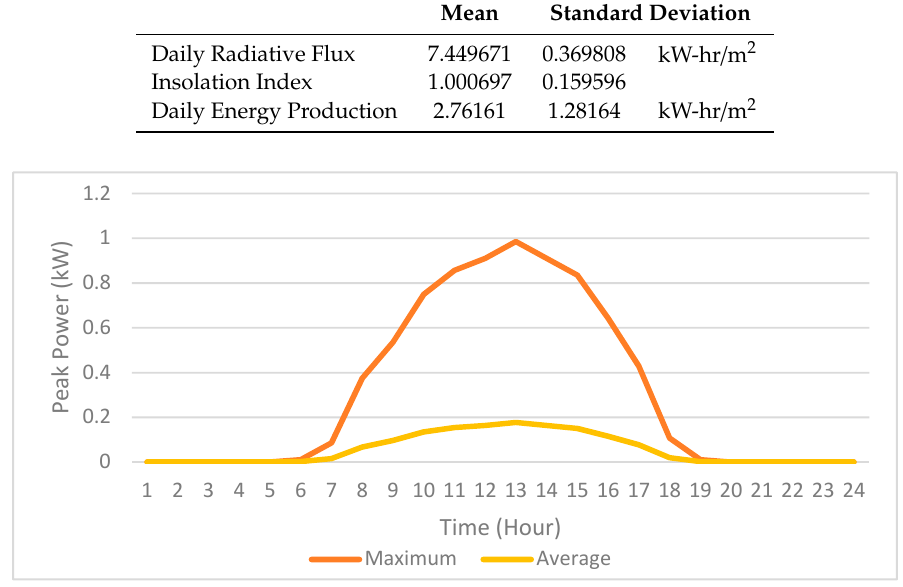
Figure 3. Solar production data.